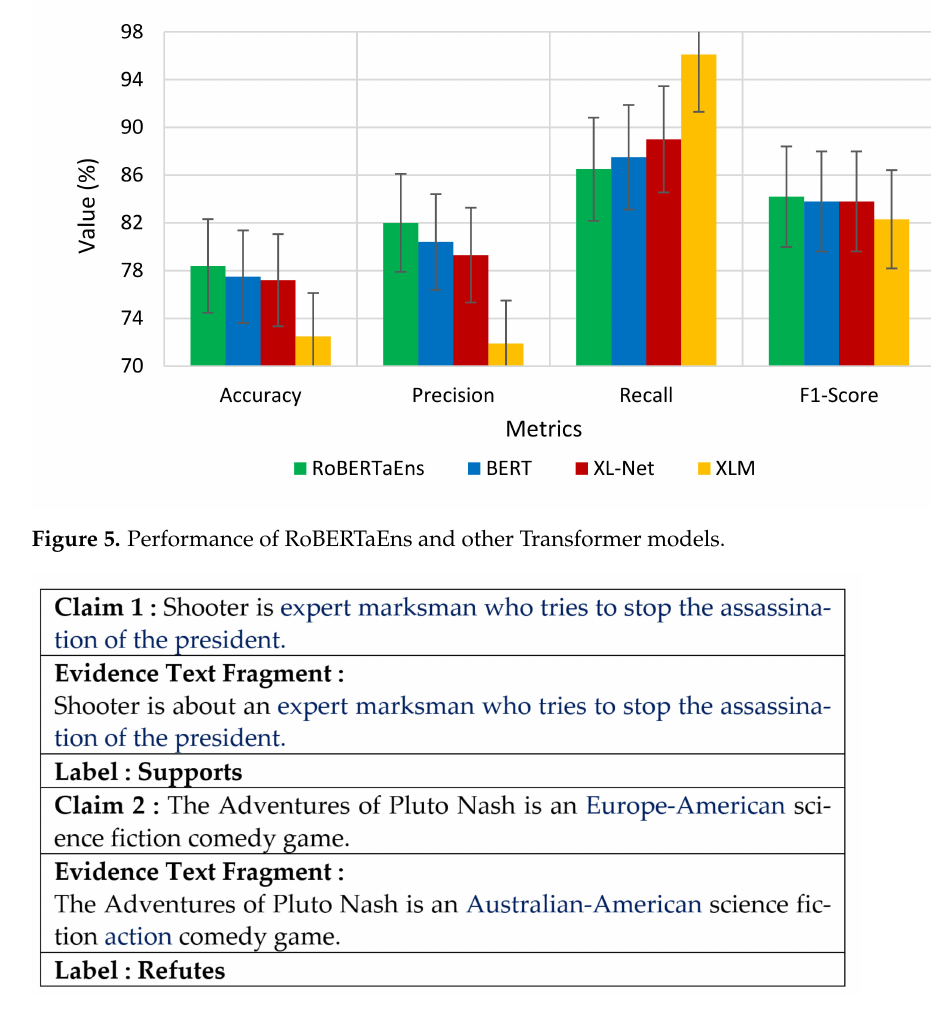
Figure 6. Fact verification